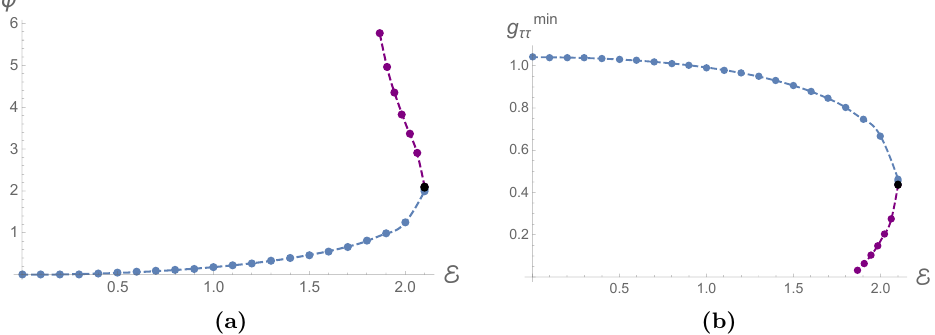
Figure 6. (a) The value of ’ at the AdS center and (b) the tt component of the metric up to maximum value of for the two branches of the AdS soliton, denoted in blue and purple, E respectively.